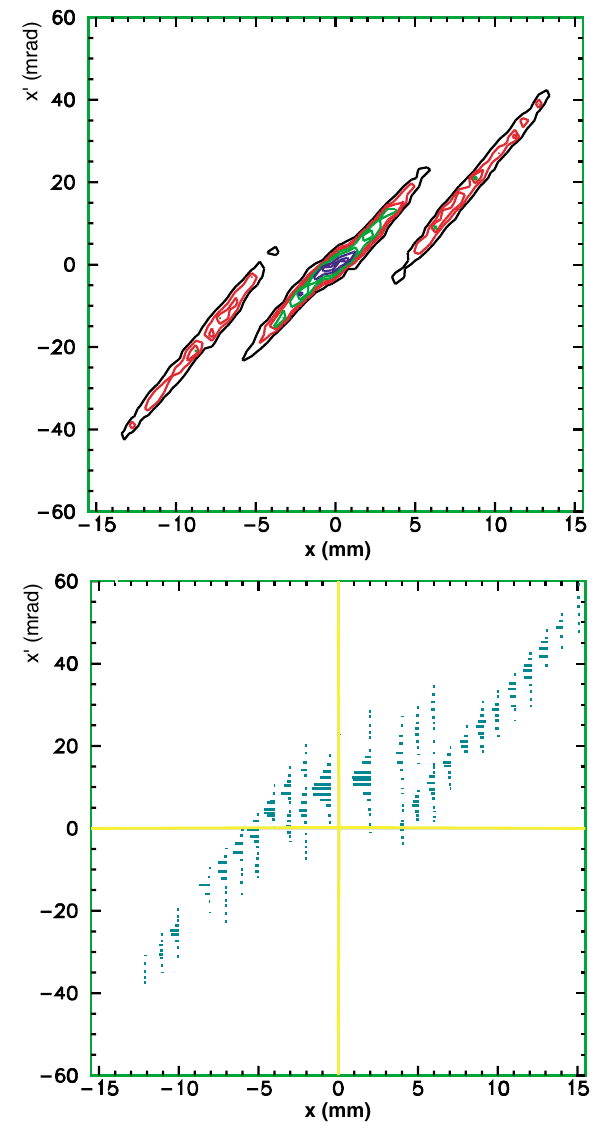
FIG. 5. (Color) Horizontal phase space measurement (bottom panel) versus PIC simulation (top panel) at the d 3 diagnostic station. For the data, the length of the horizontal bar indicates the signal amplitude measured for the phase space coordinate at the right edge of each bar. For the simulation, the central group of contour lines (10% intervals) includes the distribution of two of the four merged beams in this projection of phase